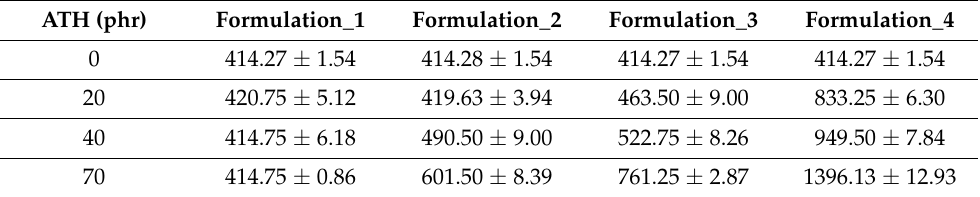
Table 3. Plateau values for different formulations of UV resin and fire-retardant filler as a function of grade and content of fillers. The standard deviation of four samples for each resin and filler blend. ATH